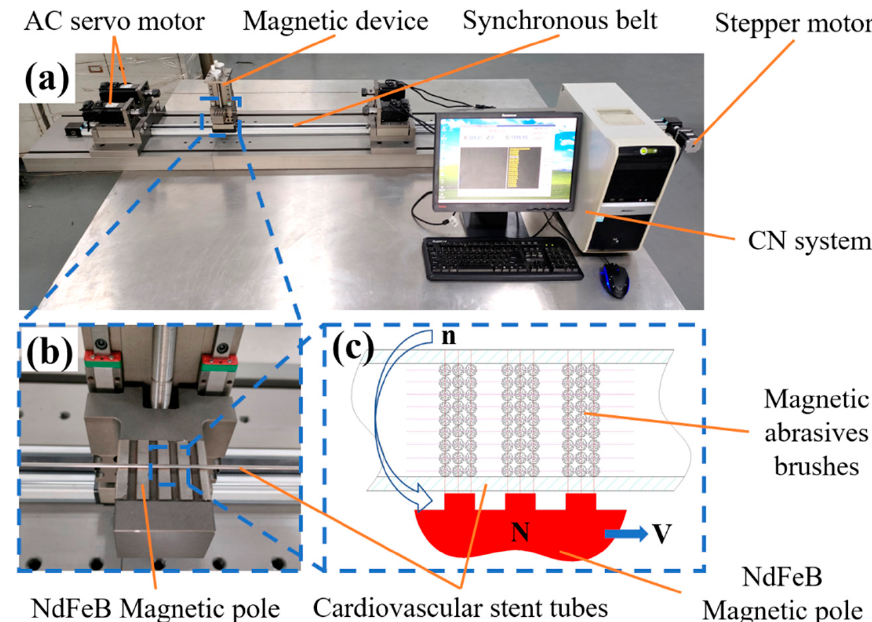
Figure 3. ( a ) MAF equipment for removing defective layers from the inner wall of ultralong cardio- vascular stents tube; ( b ) magnetic device; ( c ) processing principle.